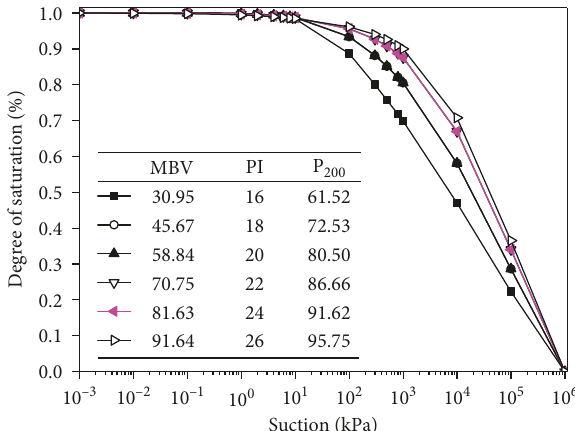
Figure 6: SWCCs with different methylene blue values.